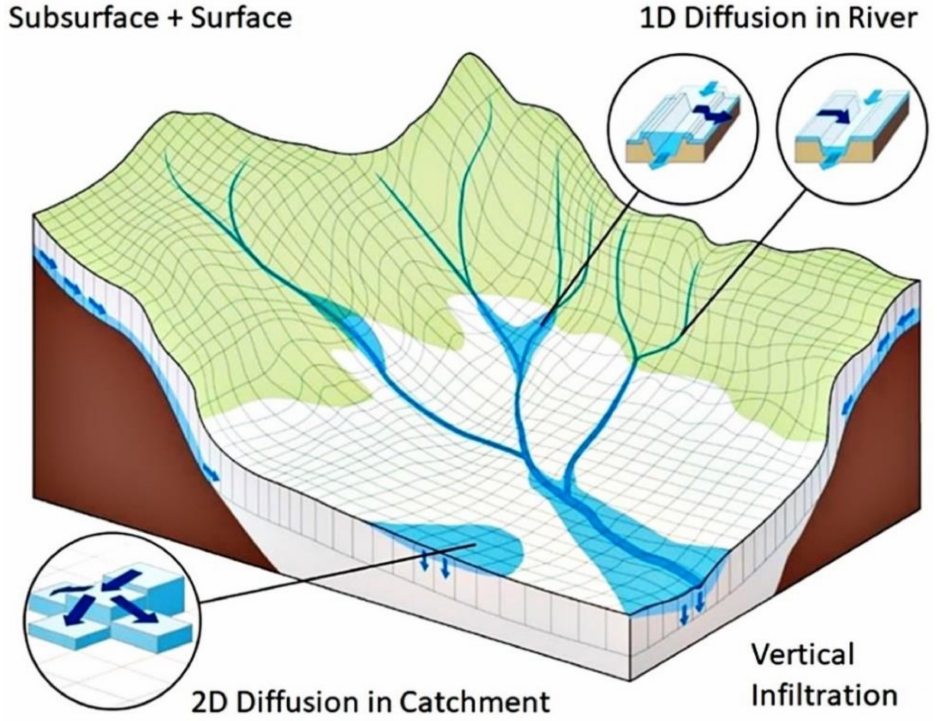
Figure 3. Schematic of the rainfall–runoff–inundation (RRI)